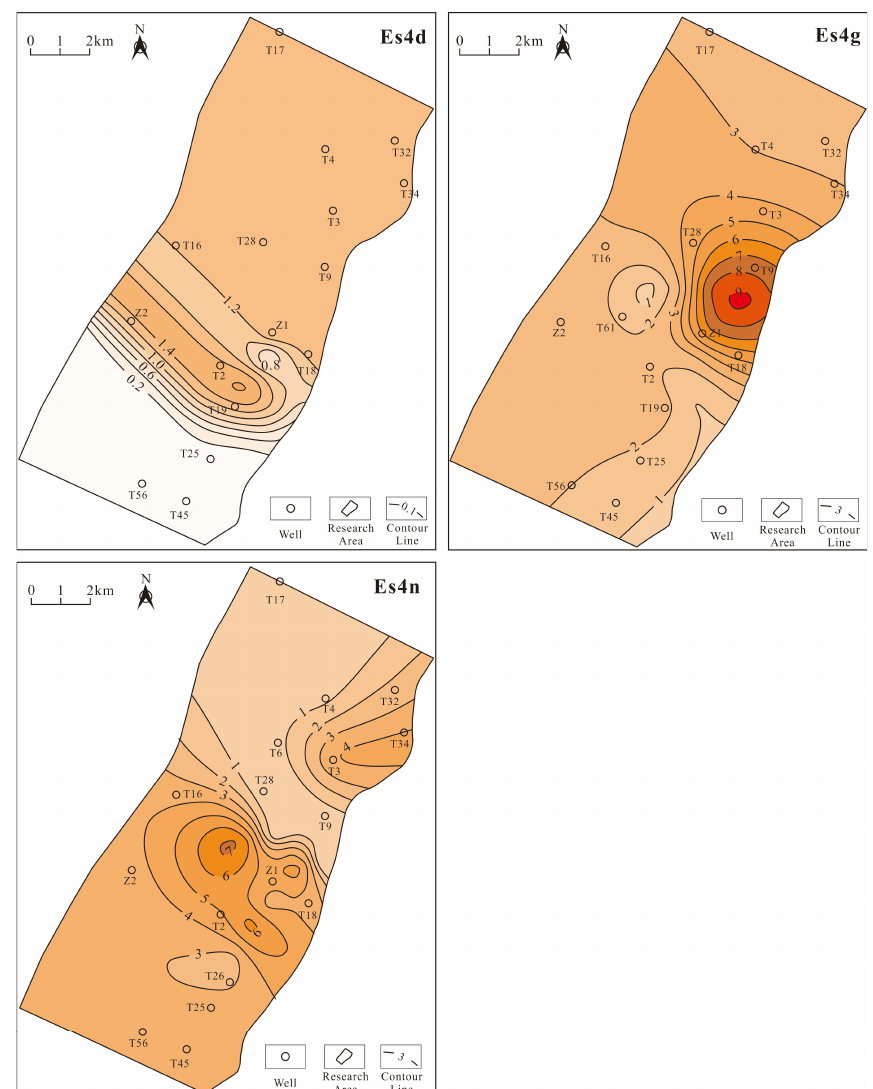
Figure 5. Source rock potential of the Es4d, Es4g, and Es4n source rocks in the Niuxintuo area. ( a ) TOC box plot. ( b ) ( S 1 + S 2 ) vs. TOC plot.